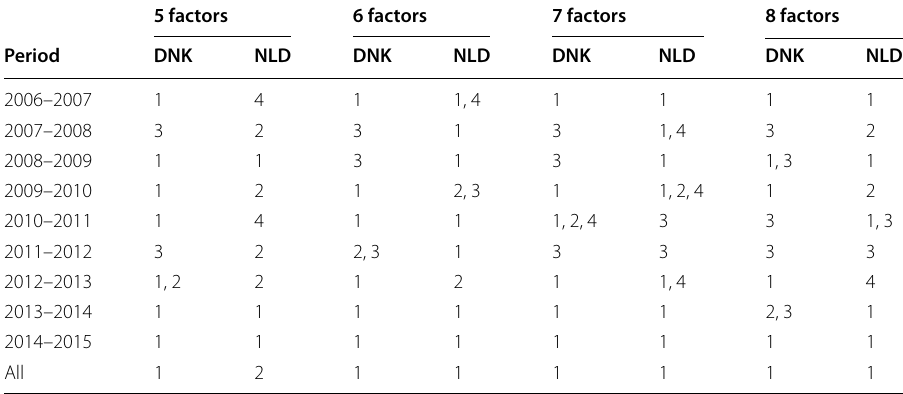
Table 3 Best-performing shortcuts to the complete additive SDA, by measured distance to the true results